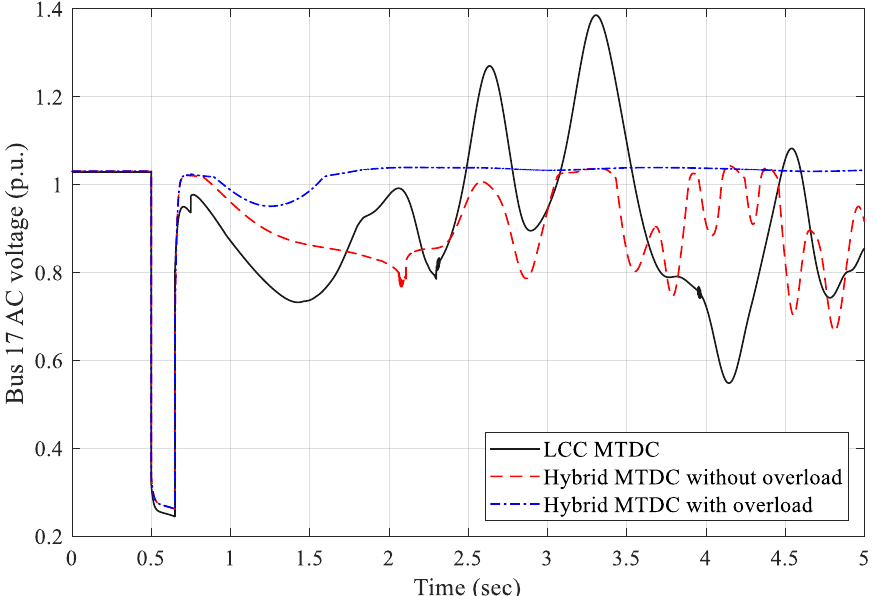
Figure 19. The AC voltage of third terminal from the simple overload simulation for each topology.